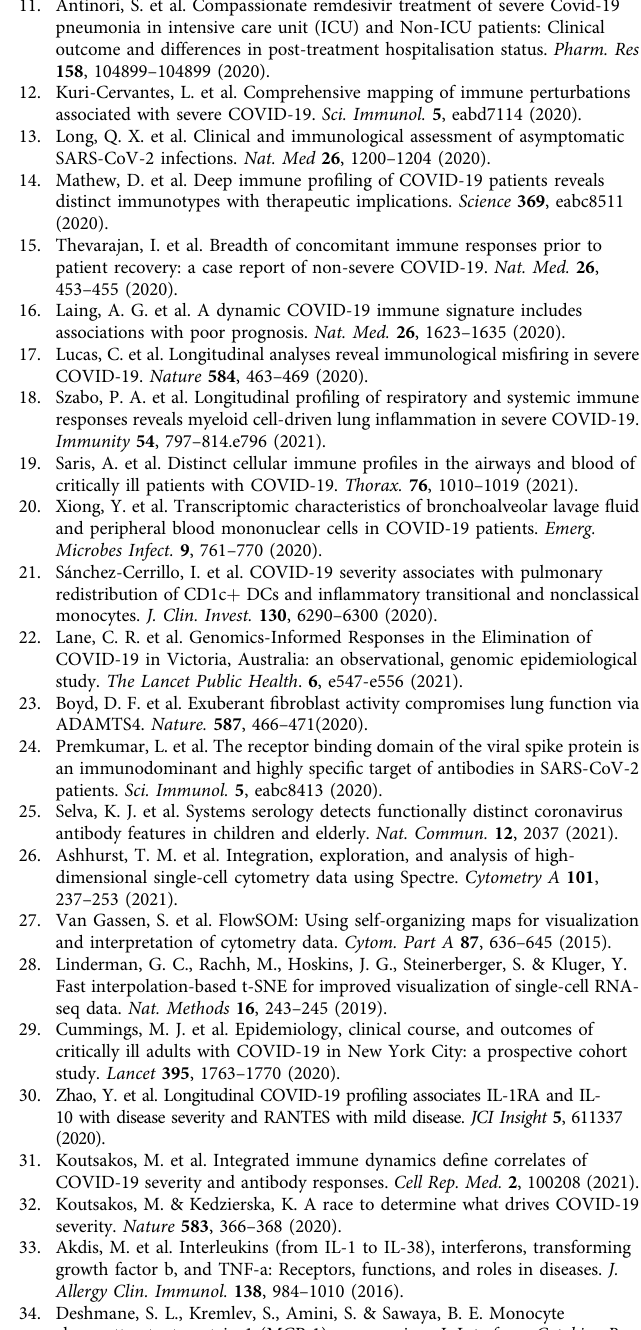
Fig. 8 Dexamethasone treatment does not alter humoral immune responses towards SARS-CoV-2 in COVID-19 patients in blood. a Levels of cytokines, soluble IL-6 receptor α (sIL-6R α ), and IL-6:sIL-6R α ratio; b anti-RBD IgM, IgG, and IgA titres, microneutralization titres; c Partial Least-Squares Discriminant Analysis (PLSDA) scores and loadings plot of antibodies against human coronaviruses; d cellular immune subset frequencies between COVID-19 patients with or without dexamethasone treatment (with/without remdesivir). n No drug V1 = 24, n No drug V7 = 13, n Drug V1 = 32, n Drug V7 = 17. The bounds of the box plot indicate the 25th and 75th percentiles, the bar indicates medians, and the whiskers indicate minima and maxima. Statistical signi fi cance was determined with a two-sided Kruskal-Wallis test followed by Dunn ’ s multiple comparisons test. Partial Least-Squares Discriminant Analysis was performed for antibodies measured with multiplex bead array assay. Volcano plots were created using a two-sided Wilcoxon rank-sum test and statistics